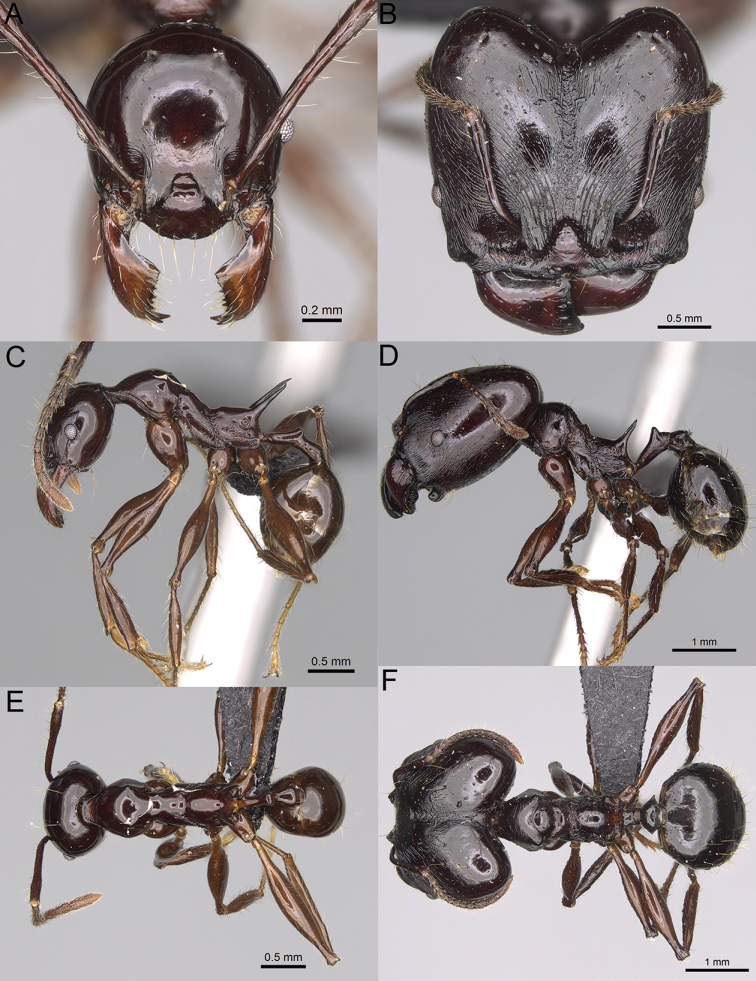
Pheidole
longispinosa Forel, full-face view (A), profile (C), and dorsal view (E) of minor worker (CASENT0451282) and full-face view (B), profile (D), and dorsal view (F) of major worker (CASENT0451284).